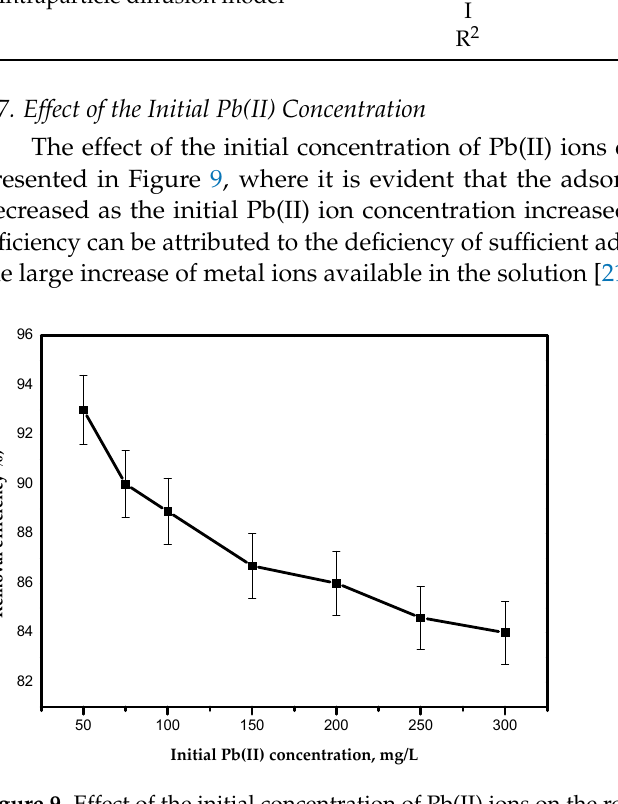
Figure 9. Effect of the initial concentration of Pb(II) ions on the removal